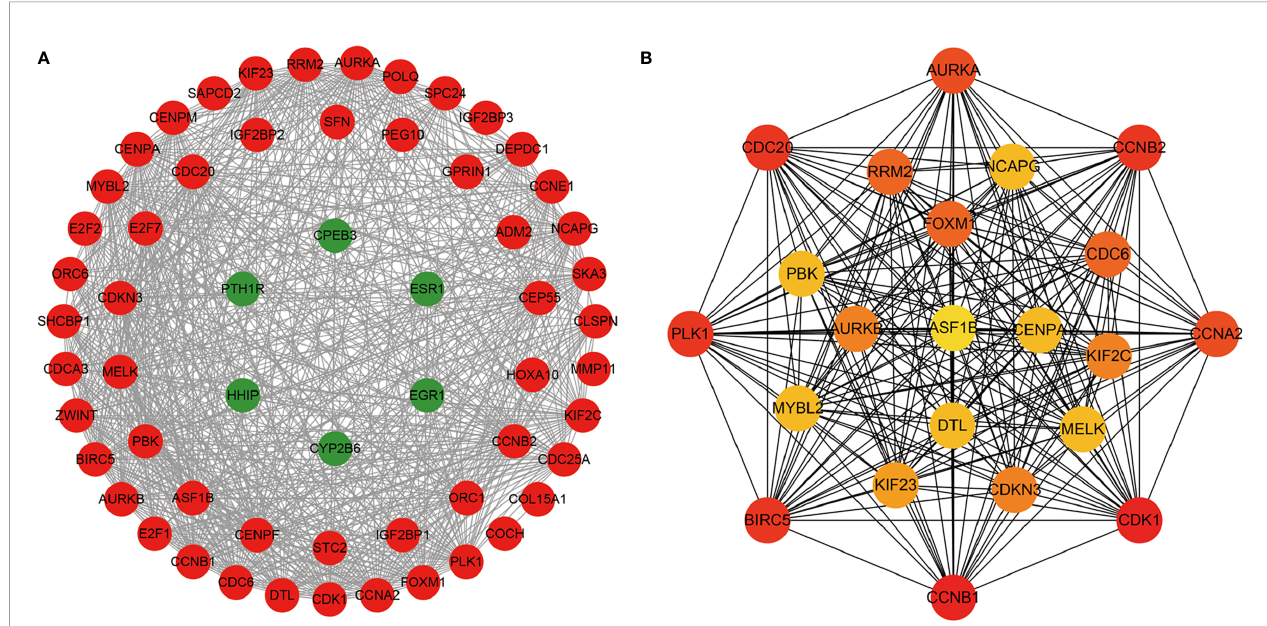
FIGURE 2 | The protein-protein interaction (PPI) network of ceRNA network-related DEMs. (A) The nodes denote DEMs (con fi dence score > 0.4) and red represent up-regulated, green represent down-regulated. (B) The hub genes with degree ≥